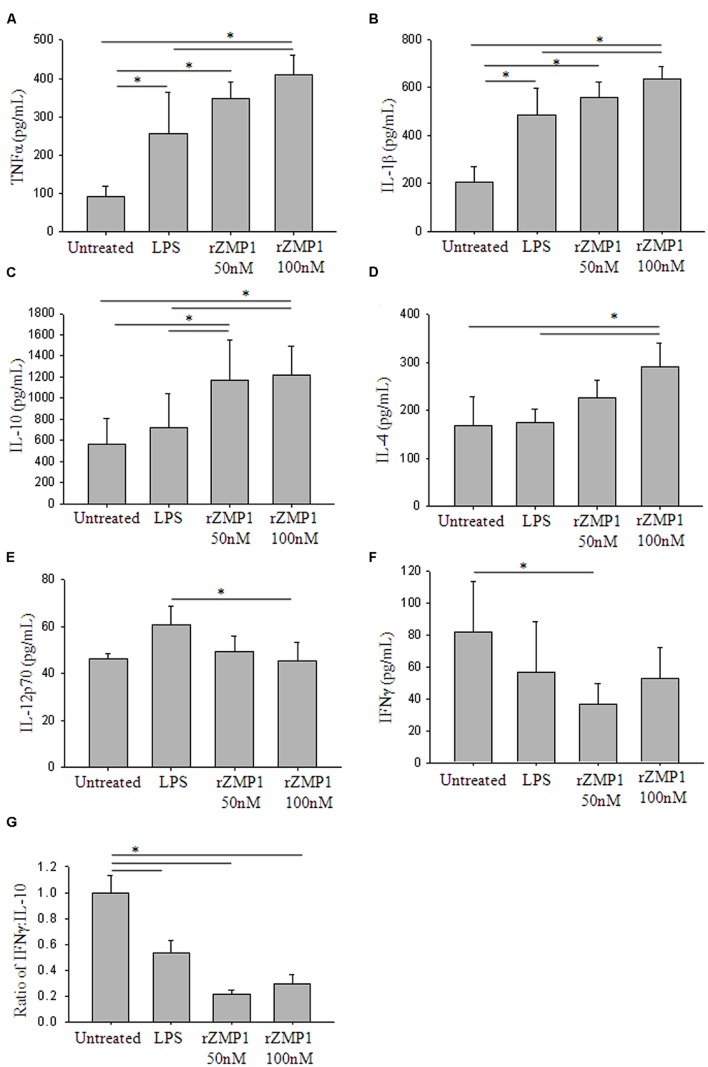
Treatment of PBMCs with recombinant Zmp1 protein inclines the immune status to Th2 response. Cytokine profiles of the PBMCs either untreated or treated with LPS, 50 nM rZmp1 and 100 nM rZmp1 was estimated. (A) TNFα, (B) IL-1β, (C) IL-10, (D) IL-4, (E) IL-12p70, (F) IFNγ titers were measured using capture ELISA. (G) Ratio of IFNγ:IL-10. All the experiments were performed more than three times. Statistical analyses were done using one-way ANOVA with Holm-Sidak multiple pair-wise comparison method. Error bars represent ±SD (standard deviation). ∗ Represents p < 0.05.